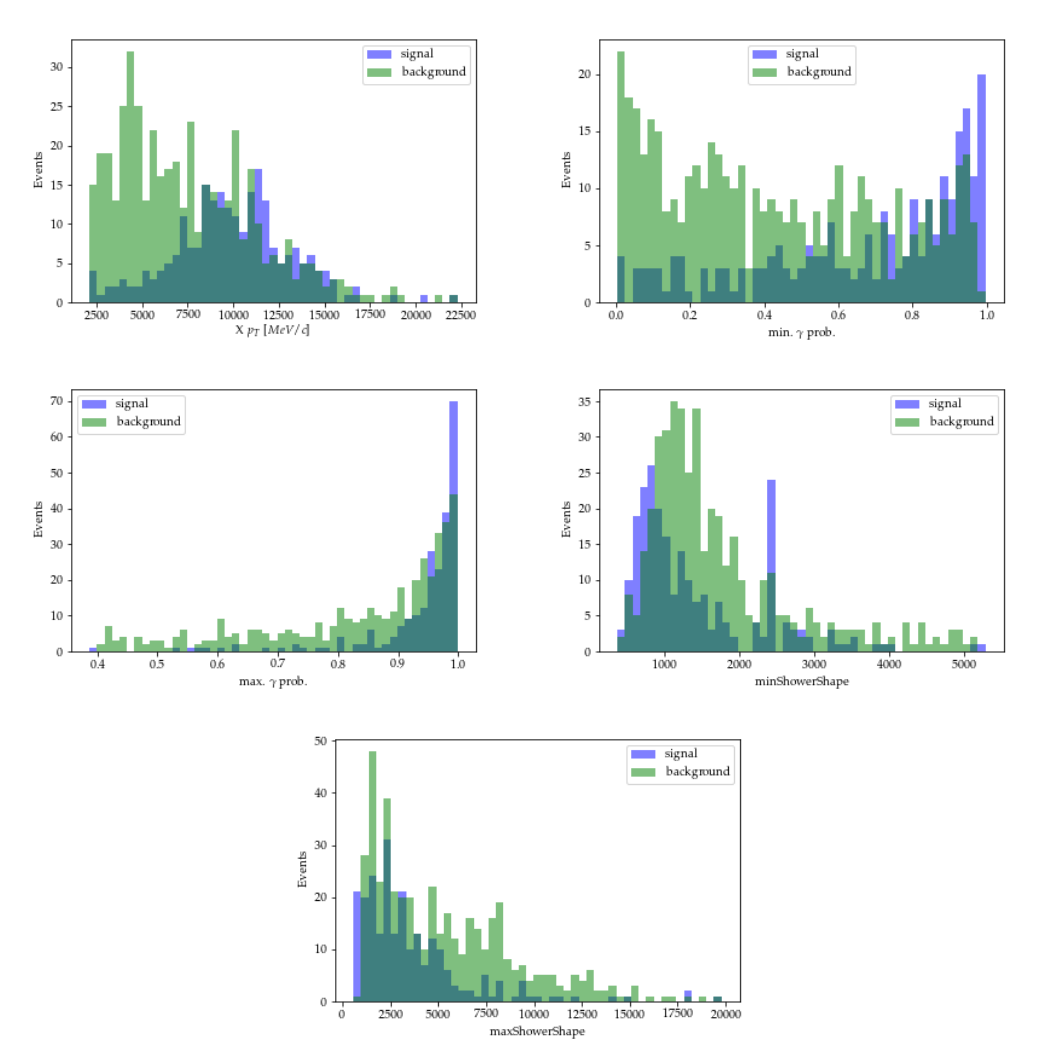
Figure 4: Signal and background distributions of information used to train the 0CV classifier. Variables are explained in the